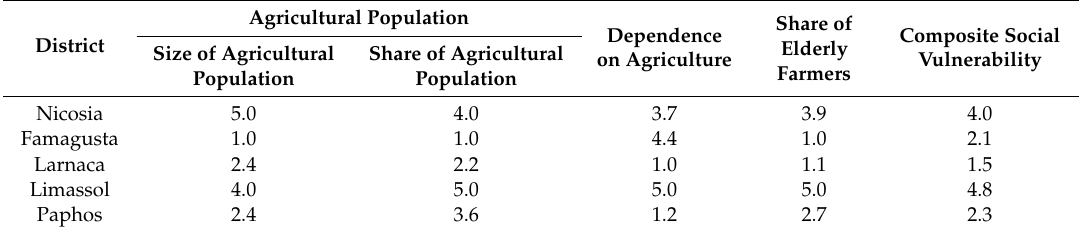
Table 10. Social vulnerability scores for each district of Cyprus (normalized).